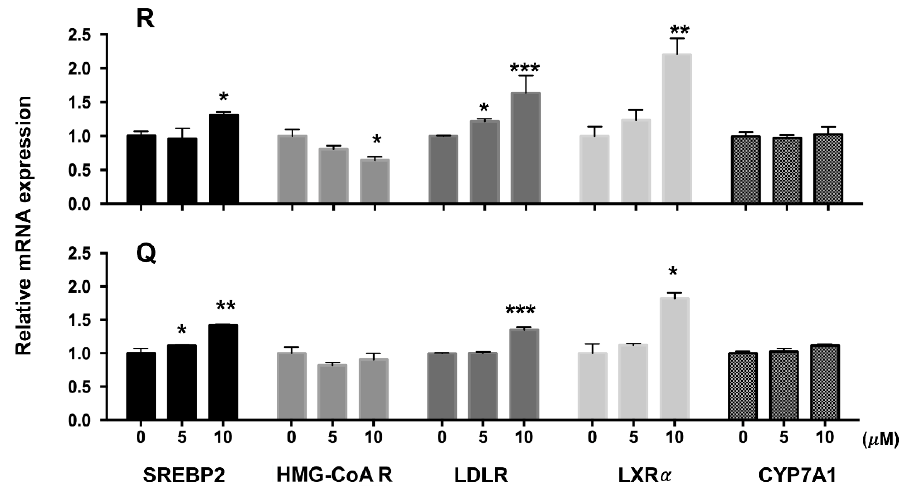
Figure 3. Effects of rutin (R) and quercetin (Q) on mRNA of SREBP2, HMG-CoA R, LDLR, and LXR α in HepG2 cells as determined by real-time PCR. HepG2 cells were incubated with 5 and 10 µM of R and Q for 24 h. Data were normalized with GAPDH. Values were expressed as means ± standard deviations (n = 3). *** p < 0.005; ** p < 0.01; or * p < 0.05 compared with the vehicle group.